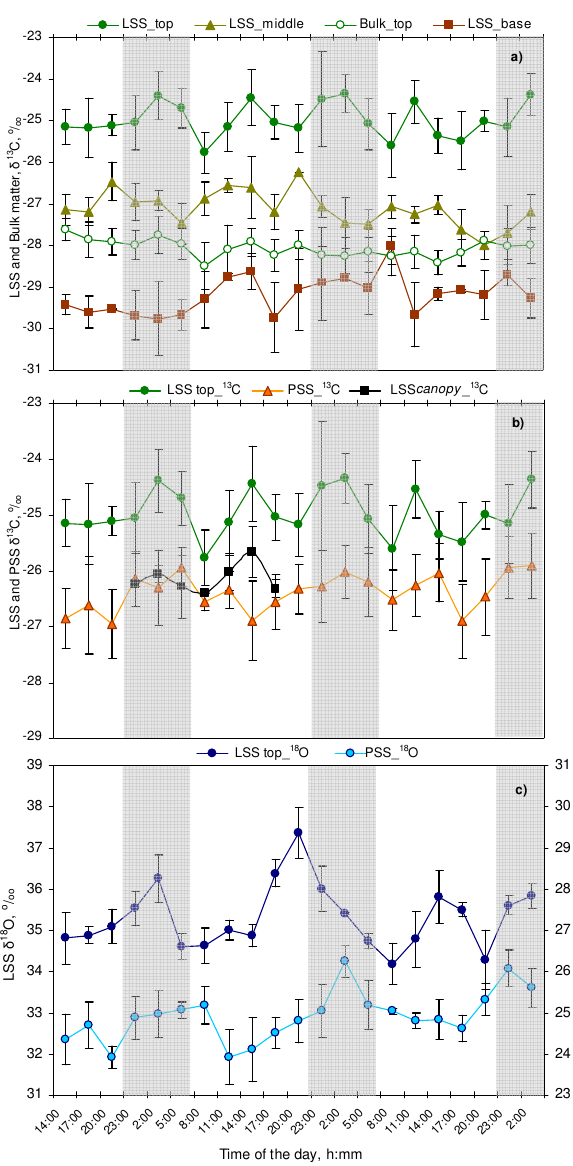
Fig. 2. (a) Dynamic of 13 C in leaf soluble sugars (LSS) of beech leaves sampled from the top, middle and base crown. Total 13 C in the bulk dry matter for the top crown leaves is also shown; (b) di- urnal variation in δ 13 C in soluble sugars in phloem exudates (PSS), sampled at breast height (1.3m), in canopy weighted δ 13 C ( δ 13 C canopy) and in LSS of the top crown leaves; (c) dynamic of δ 18 O in LSS and PSS. White and grey hatching of the graph indicate day and night periods. Bars represent the standard error of mean ( n = 4).